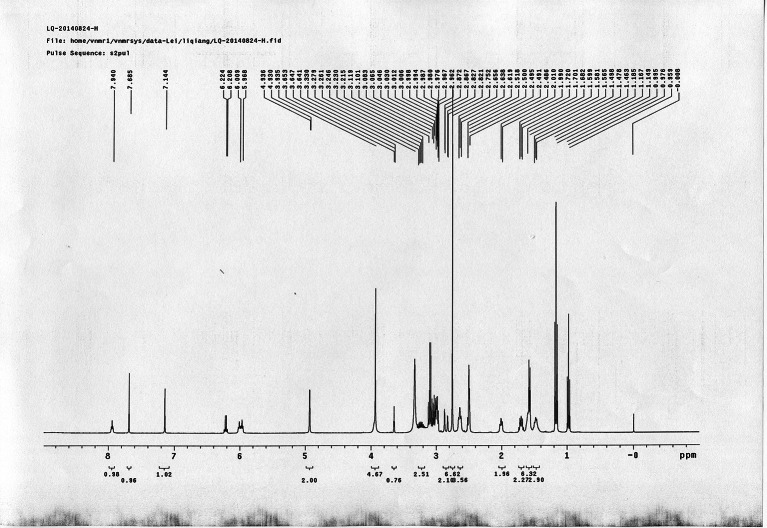
1H NMR spectra of sulfo-PL.